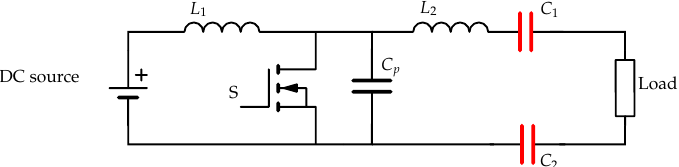
Figure 19. Class E inverter.